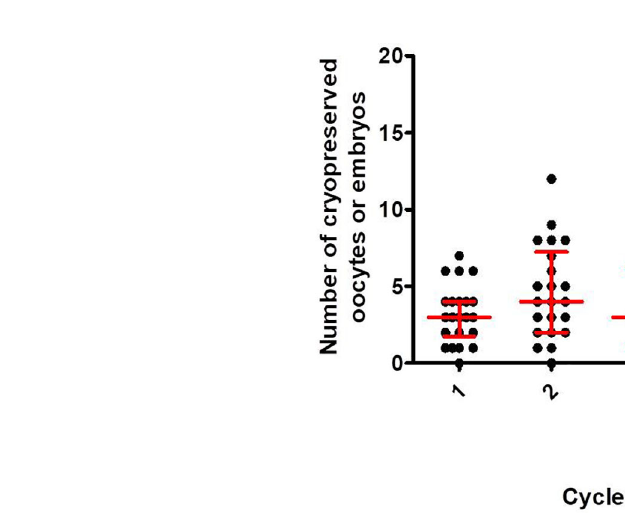
FIGURE 1 | The number of cryopreserved oocytes or embryos in the fi rst, second, third and fourth cycles and the total cumulative numbers in each patient who underwent two or more COS cycles. The horizontal line in each column represents the median value, and the upper and lower bounds represent interquartile ranges.